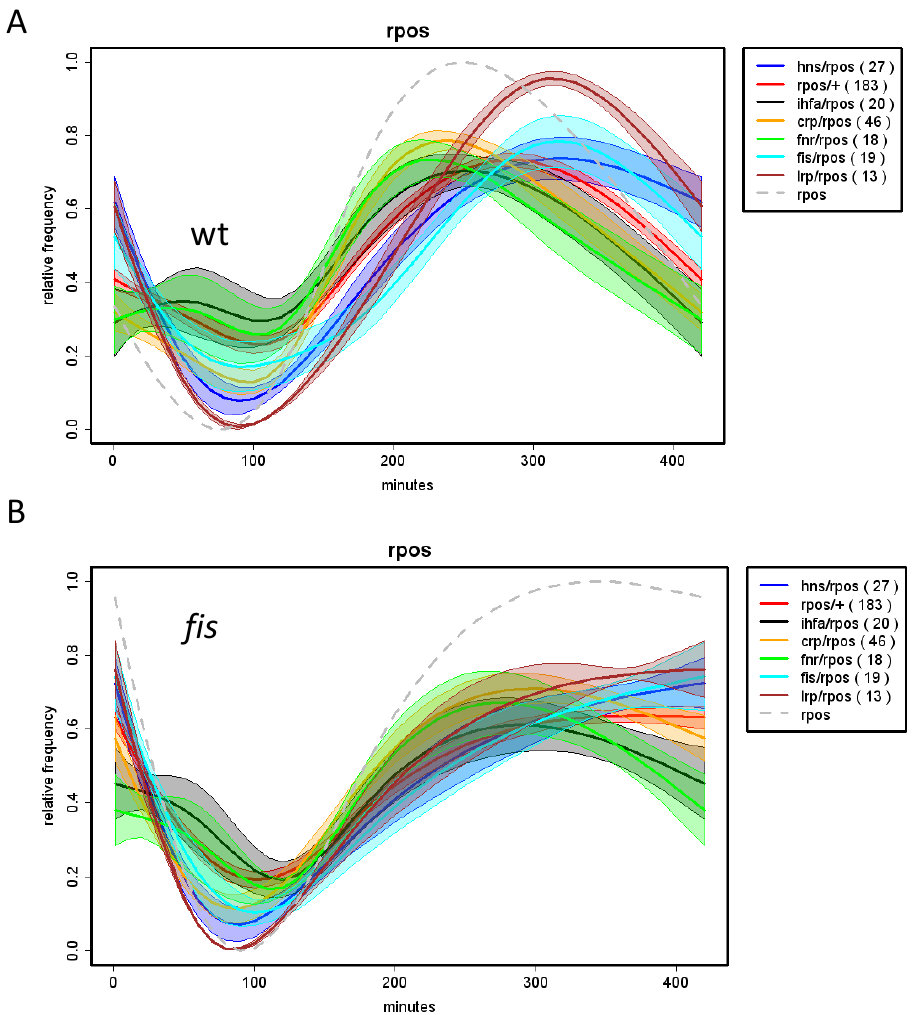
Figure 10. Modulation of the expression of ASF gene affects the temporal patterns of corresponding regulons and couplons. ( A ). Growth phase-dependent expression patterns of rpoS gene (grey dashed line), the RpoS regulon and Rpos/NAP couplons (color-coding indicated in the inset) in E. coli wild type (wt) cells. Numbers in round brackets indicate the number of genes involved in the respective regulon or couplon. Abscissa—time in minutes after inoculation of cells in fresh growth medium. The different curves were normalized to [0;1] to compare them in one plot. The envelopes of the curves indicate the standard deviation at 10% random remapping of the expression patterns to genes. ( B ). The same as in ( A ) but in the fis mutant cells. Note that mutation of fis gene alters the expression pattern of both, the rpoS gene and RpoS regulon, as well as RpoS couplons (data from [29]). The experimental procedure was as described in the legend to Figure